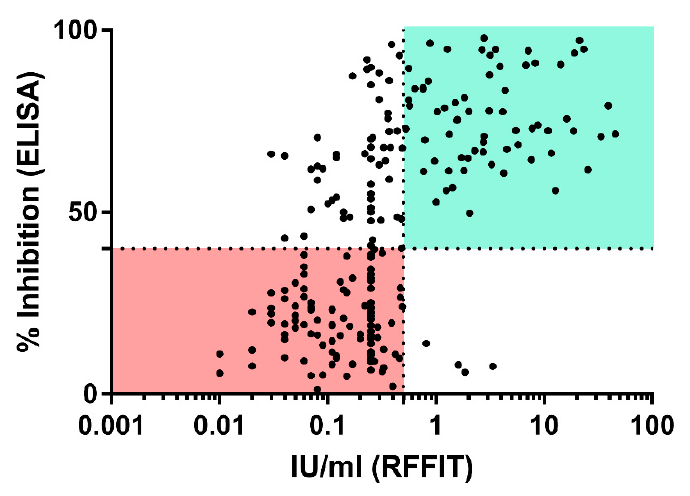
Figure 5. Correlation between ELISA (y-axis) and RFFIT ( x -axis) results. The dotted lines represent the threshold of positivity in ELISA (horizontal; 40% PI) and RFFIT (vertical, 0.5 IU / mL). Sectors from both assays that are considered negative and positive are highlighted in light green and light red, respectively.